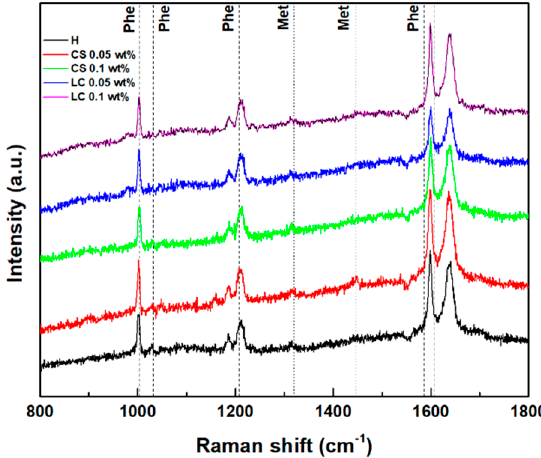
Figure 5. Raman scattering spectra of the hydrogel and magnetogels containing lipid-coated (LC) and citrate-stabilized (CS) nanoparticles. Vertical lines represent the reported Raman shifts of methionine (Met) and phenylalanine (Phe).